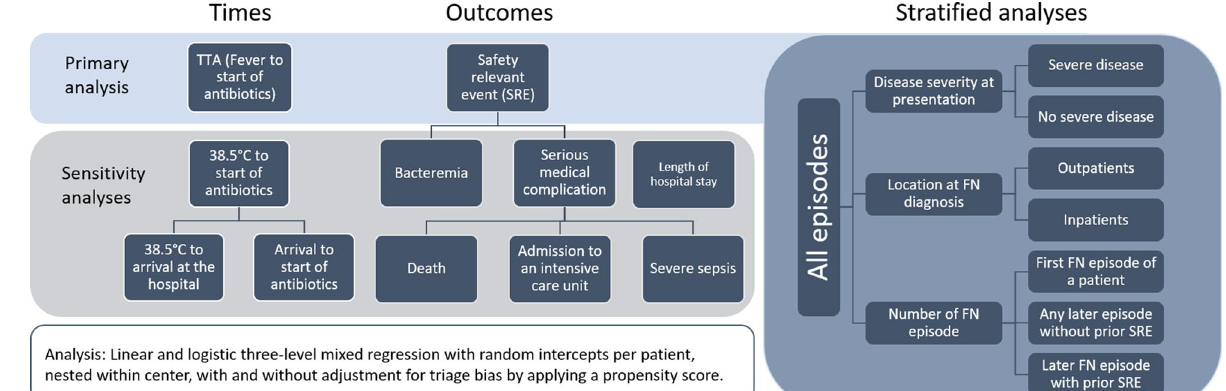
Figure 1. Scheme of analyses: Times, outcomes and stratified